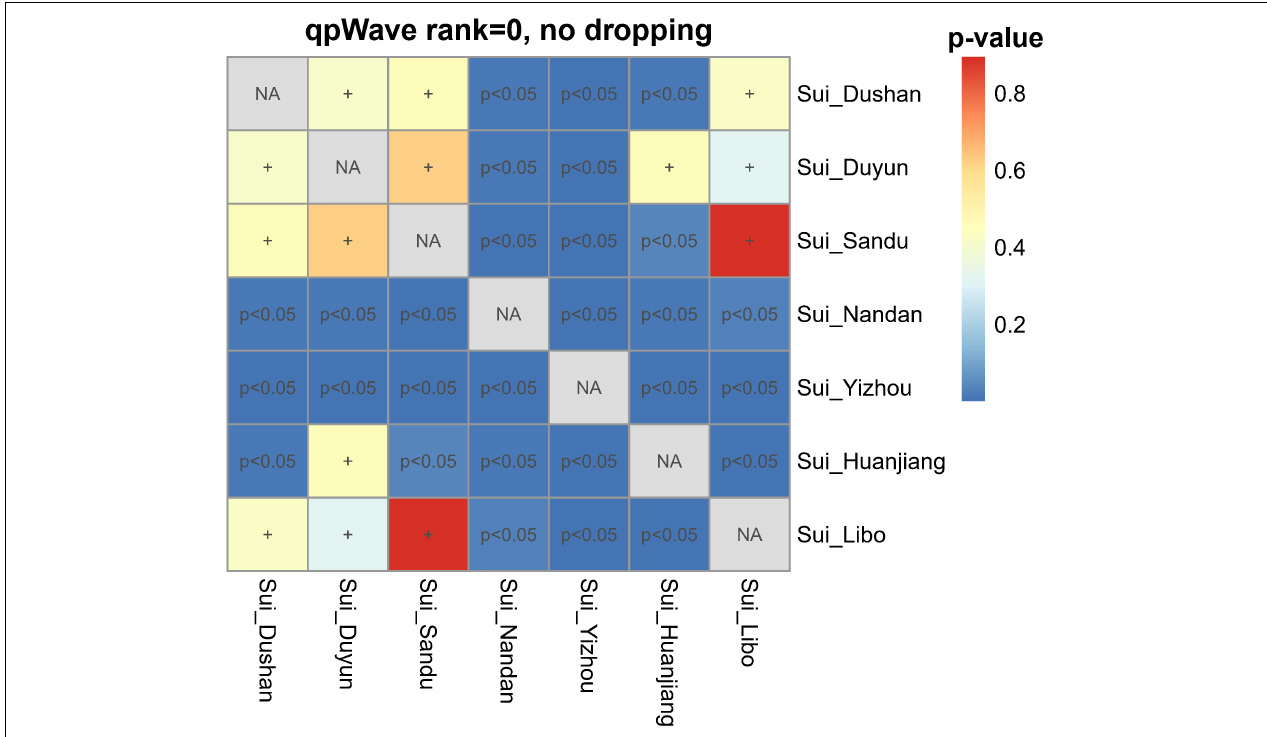
FIGURE 6 | Testing the genetic homogeneity of pairwise Sui populations. Heatmap showed p -values (rank = 0) of pairwise qpWave in Guizhou and Guangxi Sui populations. The p -value > 0.05 was noted as +, indicating this pair of studied Sui groups derived from a single homogeneous population relative to a set of